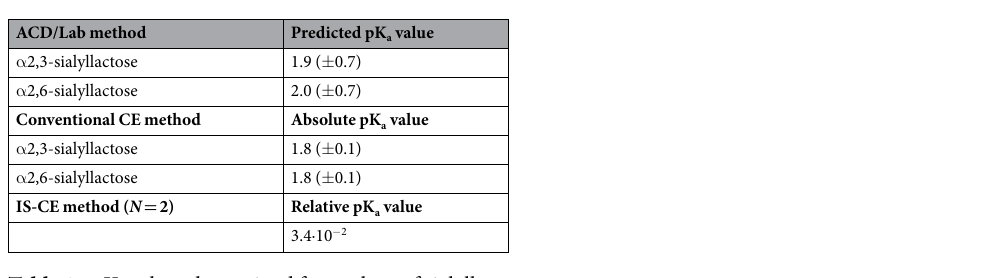
Table 1. pK a values determined for analogs of